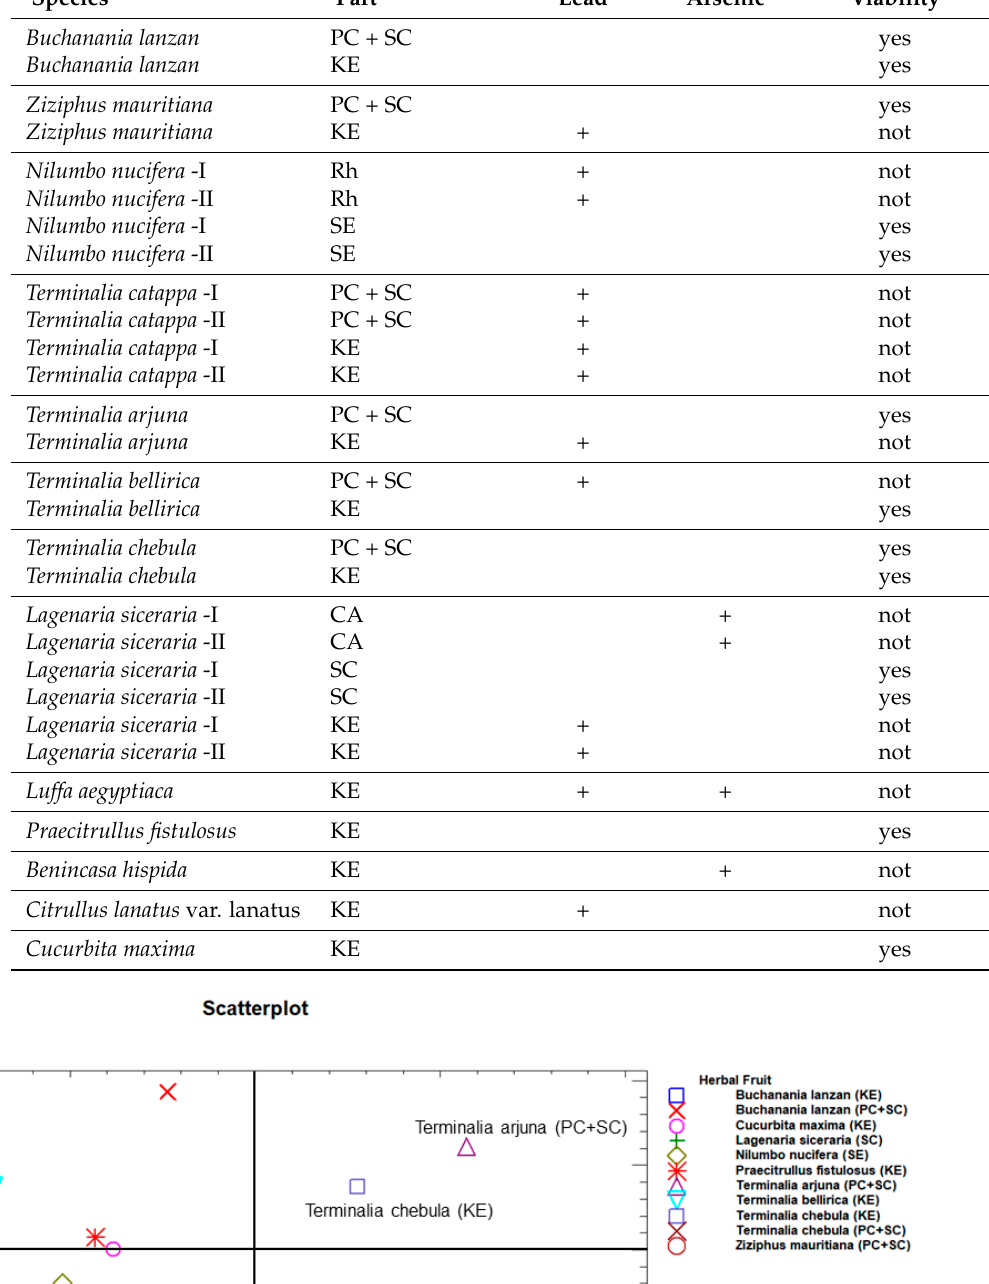
Table 4. Viability of herbal fruits based on their lead and arsenic content.